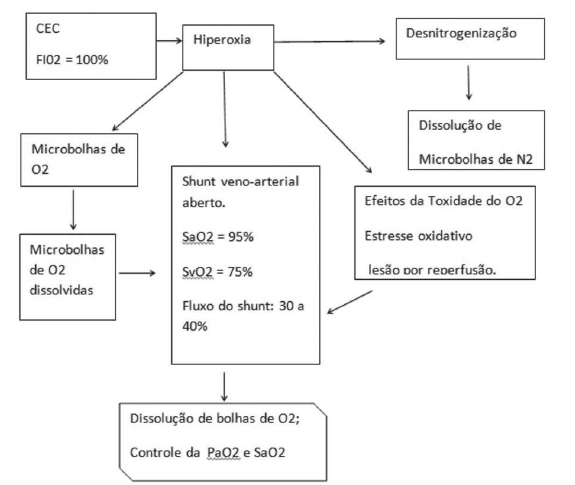
Fig. 7 - O fluxograma demonstra como o shunt venoarterial poderia controlar a hiperoxia utilizada para produzir desnitrogenização do